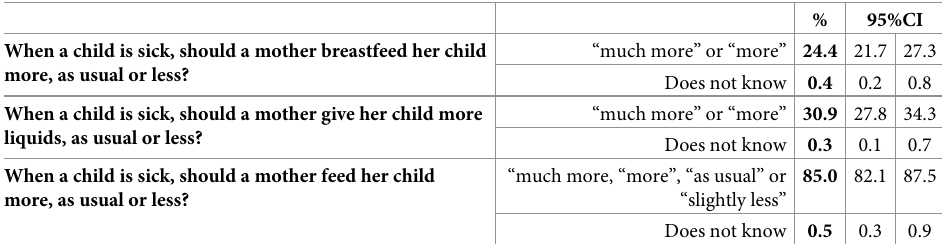
Table 4. Knowledge of child feeding practices during an episode of illness (N =